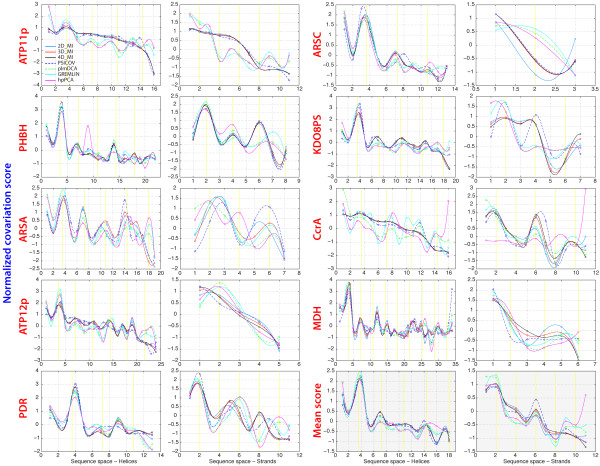
Distance dependent covariation signal and secondary structure. For each secondary structure element (helices and strands), the average normalized covariation score was based on the sequence distance relative to an initial position. Curves connecting the average covariation scores at each sequence distance are drawn as cubic splines. Vertical yellow lines indicate the expected secondary structure period. The lower right two panels show the averaged scores for all 9 protein families.